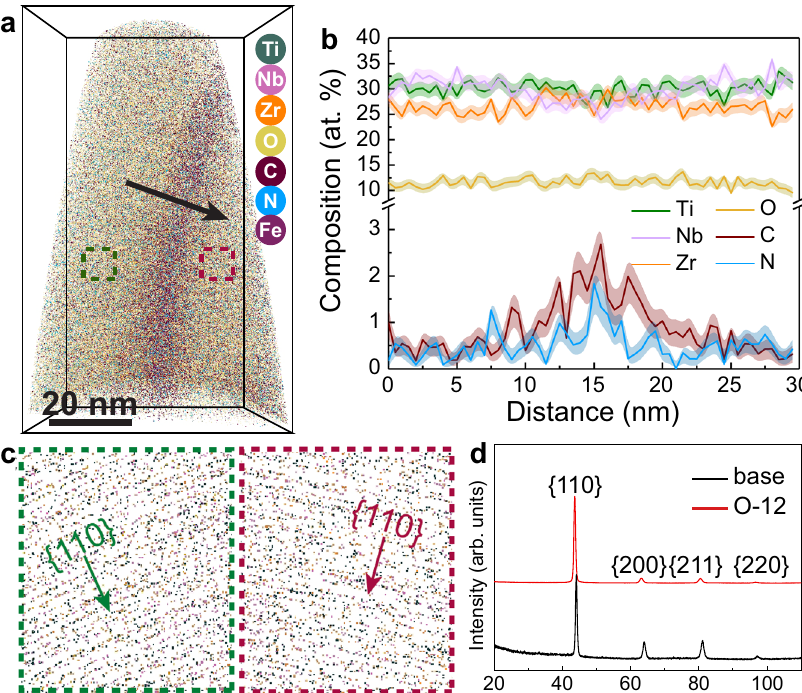
Fig. 2 APT and XRD characterization of the O-12 MISS alloy. a Side-view of the three-dimensional reconstruction of a typical APT dataset. b 1D compositional pro fi le measured along the length direction of the arrow displayed in a , showing that C and N are enriched at the grain boundary. c Thin slice through the APT dataset revealing two sets of {110} atomic planes. The lattice spacing is 0.24nm. The positions of the two families of {110} planes are indicated by the rectangles in a . d XRD patterns of the O-12 and base alloys, presenting single-phase bcc